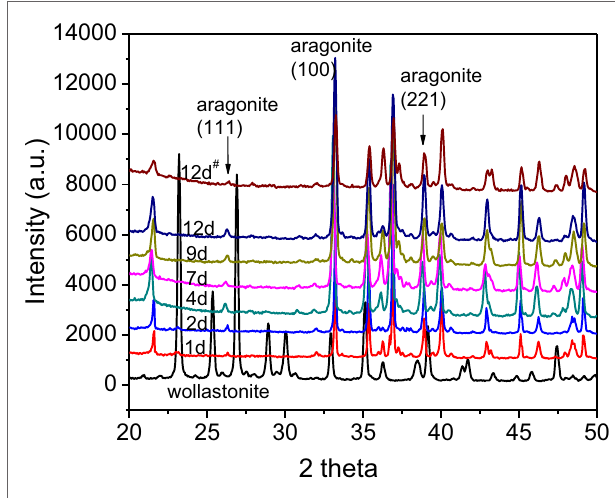
FigUre 2 | X-ray diffraction spectra of the reacted casiO 3 powder at varying time via the “solution replacement” process, 12-day of “single process” (12-day # ), and the original casiO 3 powder .